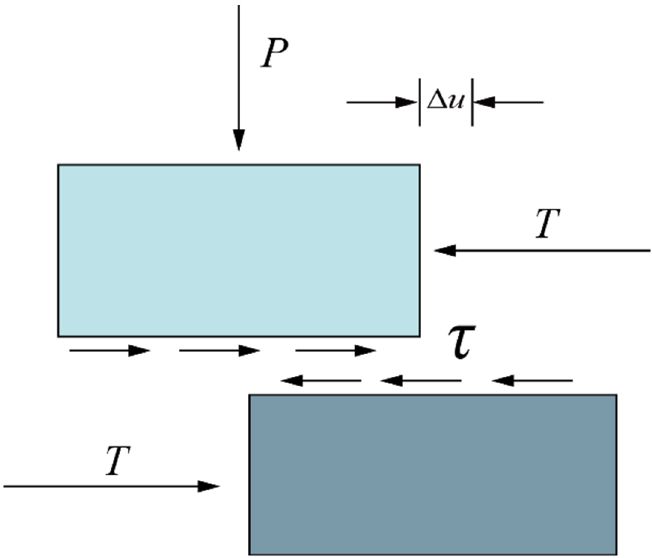
Figure 2. Goodman mechanical model.